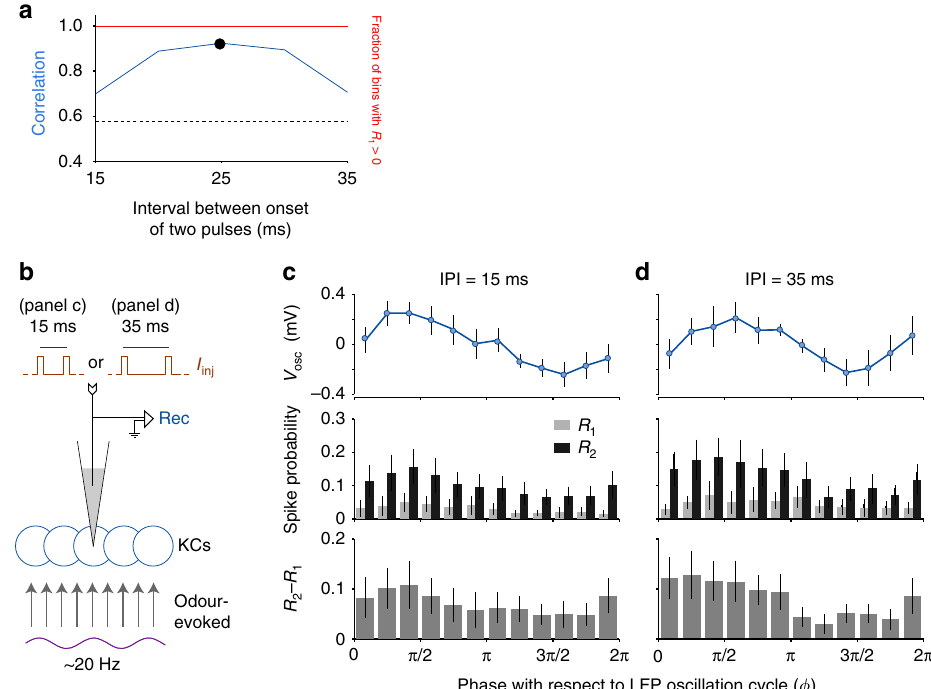
Figure 6 | Integration windows are robust to variations in the inter-stimulus interval. ( a ) The computational model predicted phase-dependent summation for a range of intervals between the two pulse inputs. ( b ) In vivo test: the experiment shown in Fig. 1, including odour-elicited oscillations, was repeated with two different inter-pulse intervals (IPIs); LFP electrode is not shown. ( c ) For 15-ms IPI, subthreshold oscillations and the effect of summation are phase-locked and correlated ( n ¼ 18 KCs). ( d ) The same result was obtained for 35-ms IPI ( n ¼ 13 KCs). Error bars represent